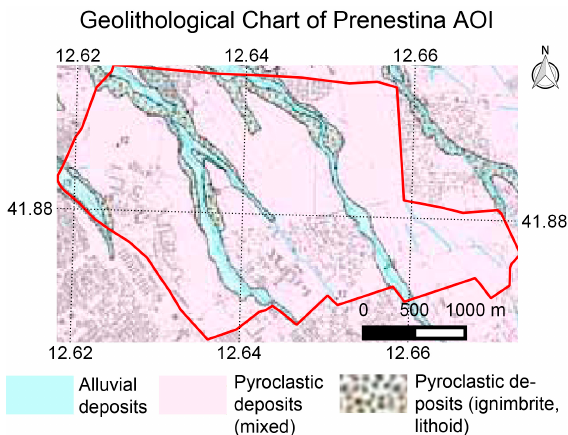
Figure 26. Agropedological chart of Prenestina AOI (shown in red polygon), last updated in 2007. Copyright: Comune di Roma [73].